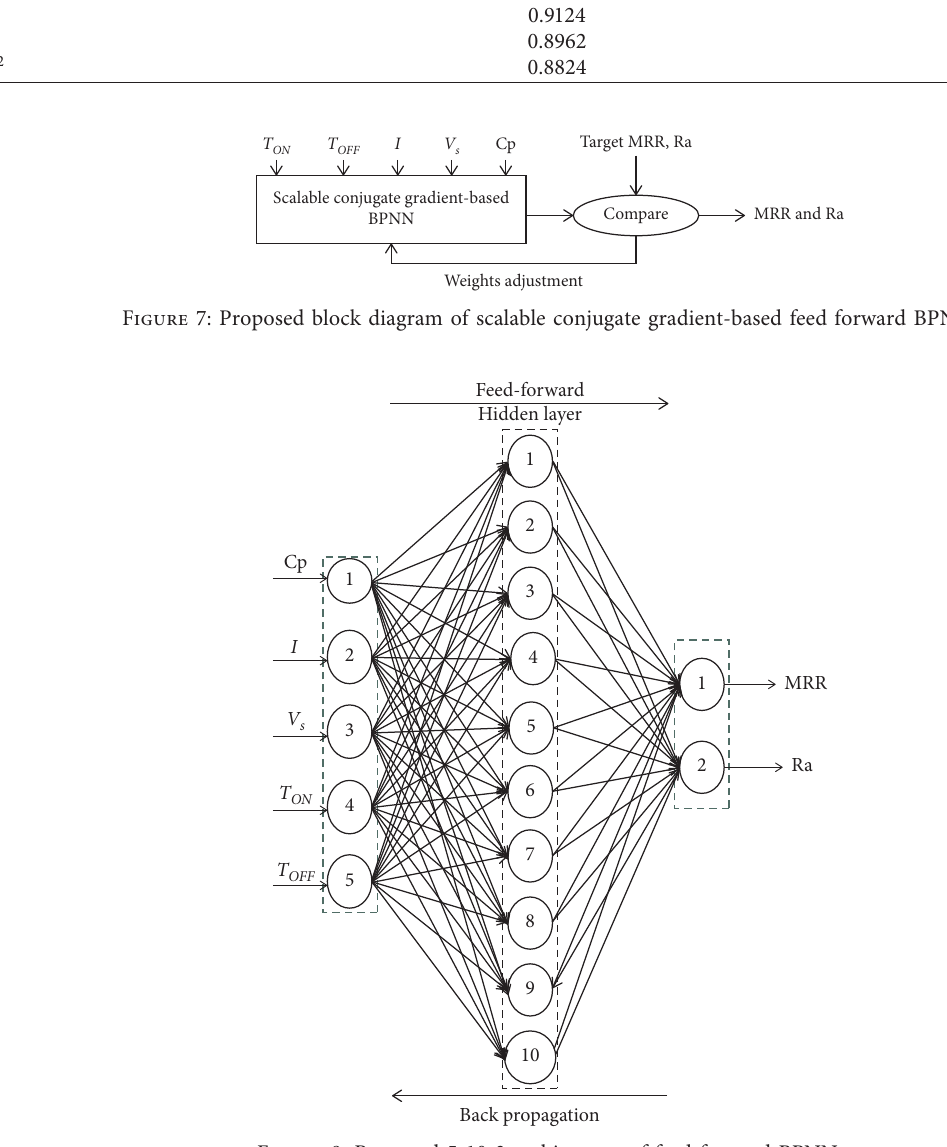
Figure 8: Proposed 5-10-2 architecture of feed forward